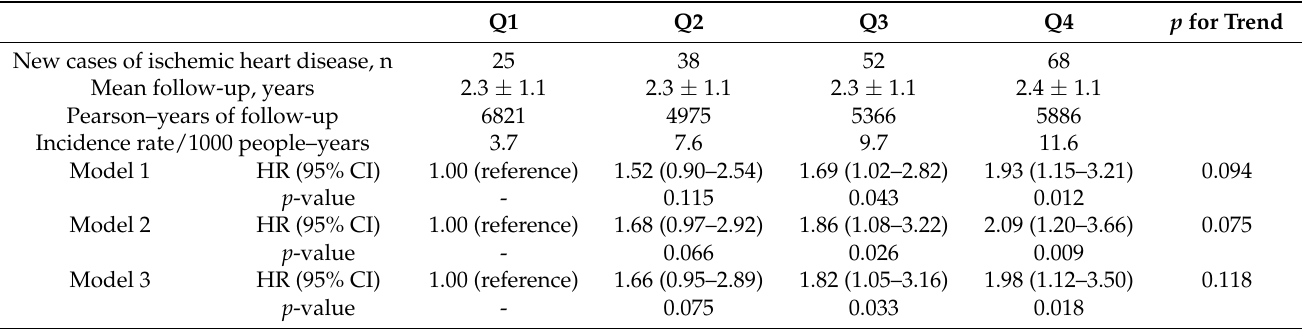
Table 2. Hazard ratios (95% confidence intervals) for the incidence of ischemic heart disease. Q1 Q2 Q3